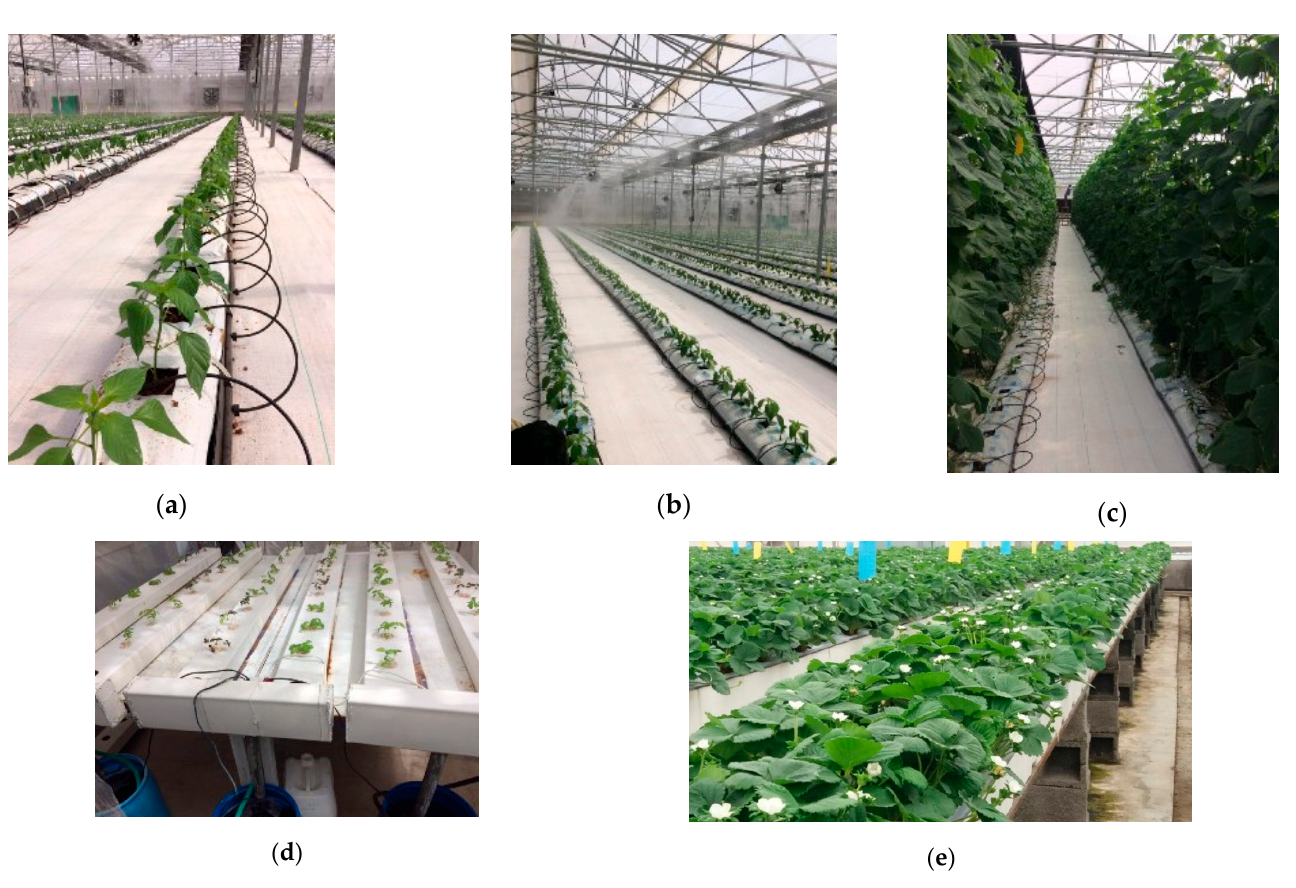
Figure 6. ( a ) Hydroponic greenhouse of the VRU; ( b ) Controlled-environment system of VRU’s greenhouse; ( c ) Hydroponic greenhouse of VRU; ( d ) Hydroponic system developed by researchers of VRU; ( e ) Hydroponic systems installed in VRU’s greenhouse.